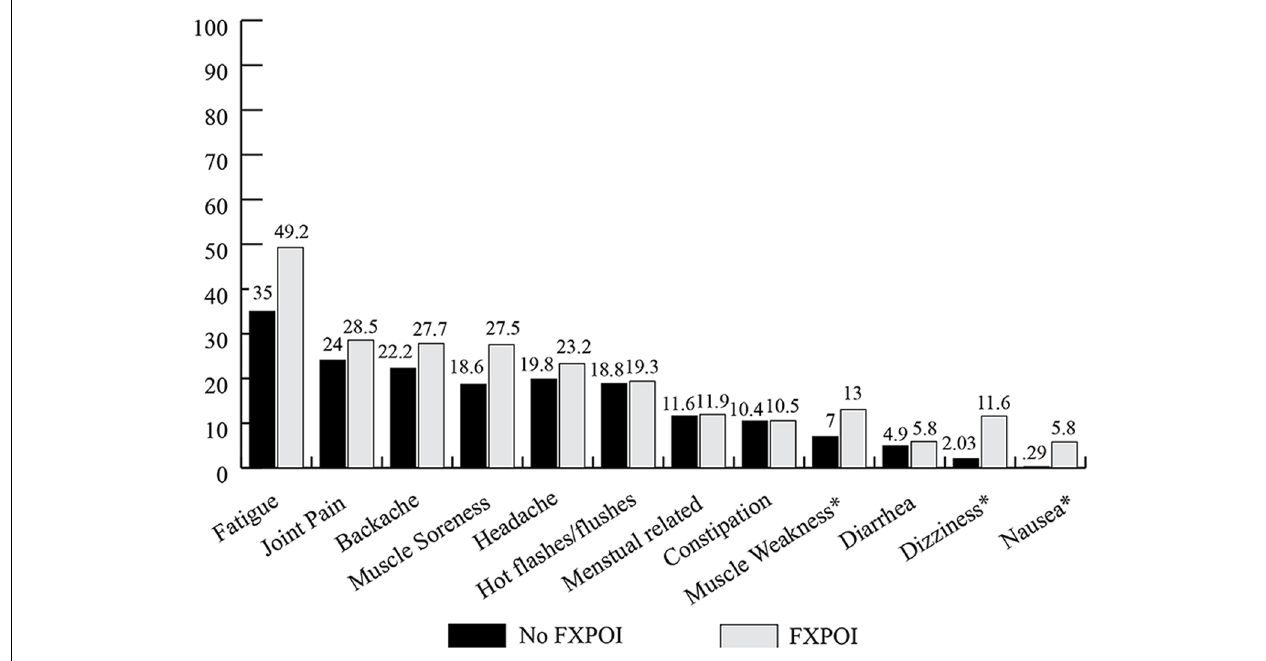
FIGURE 5 | Percentage of women with and without FXPOI endorsing having experienced specific physical health symptoms “often or very often” in the previous 30 days. *Significant differences between